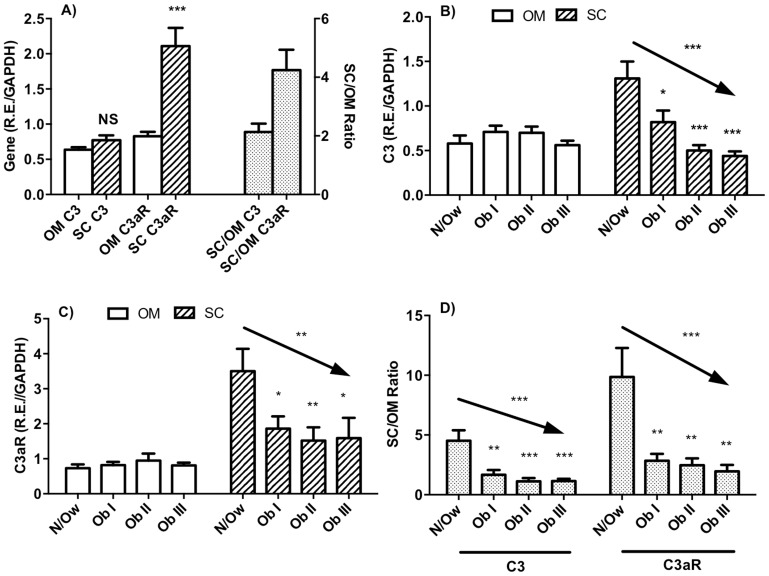
Expression levels of the target mRNAs in adipose tissue altogether and in normal/overweight and obese groups.Gene expression was determined by RT-qPCR and is presented as relative expression (R.E.) relative to housekeeping gene GAPDH. A) Expression of genes C3 and C3aR in OM and SC and ratio of SC to OM adipose tissue, B) and C) C3 and C3aR adipose tissue expression in N/Ow group and increasing obesity groups in OM and SC adipose tissue, and D) SC to OM adipose tissue expression level ratio of C3 and C3aR in N/Ow and various grades of obesity groups. Data is expressed as mean±SEM where *p<0.05, **p<0.01 and ***p<0.0001 and pNS indicates not significant.